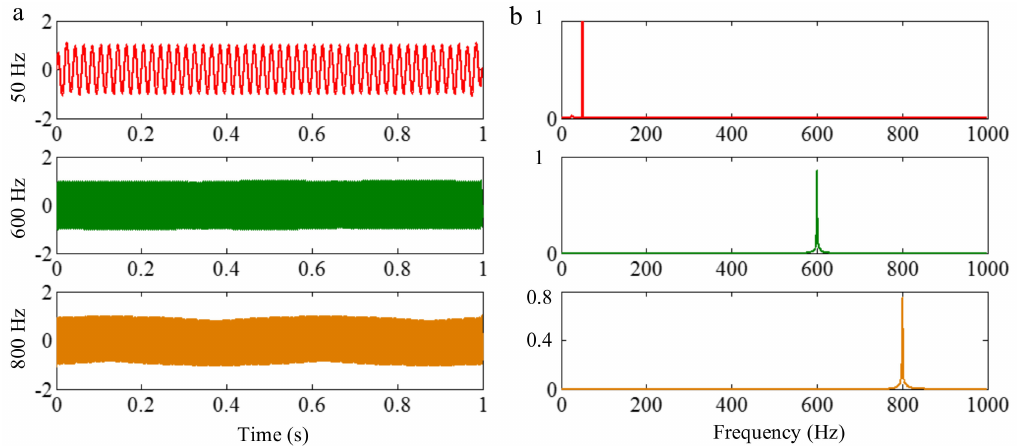
Figure 24. The waveforms of EWT result of f sig 5 and the corresponding Fourier spectrums: ( a ) waveforms and ( b ) Fourier spectrums.